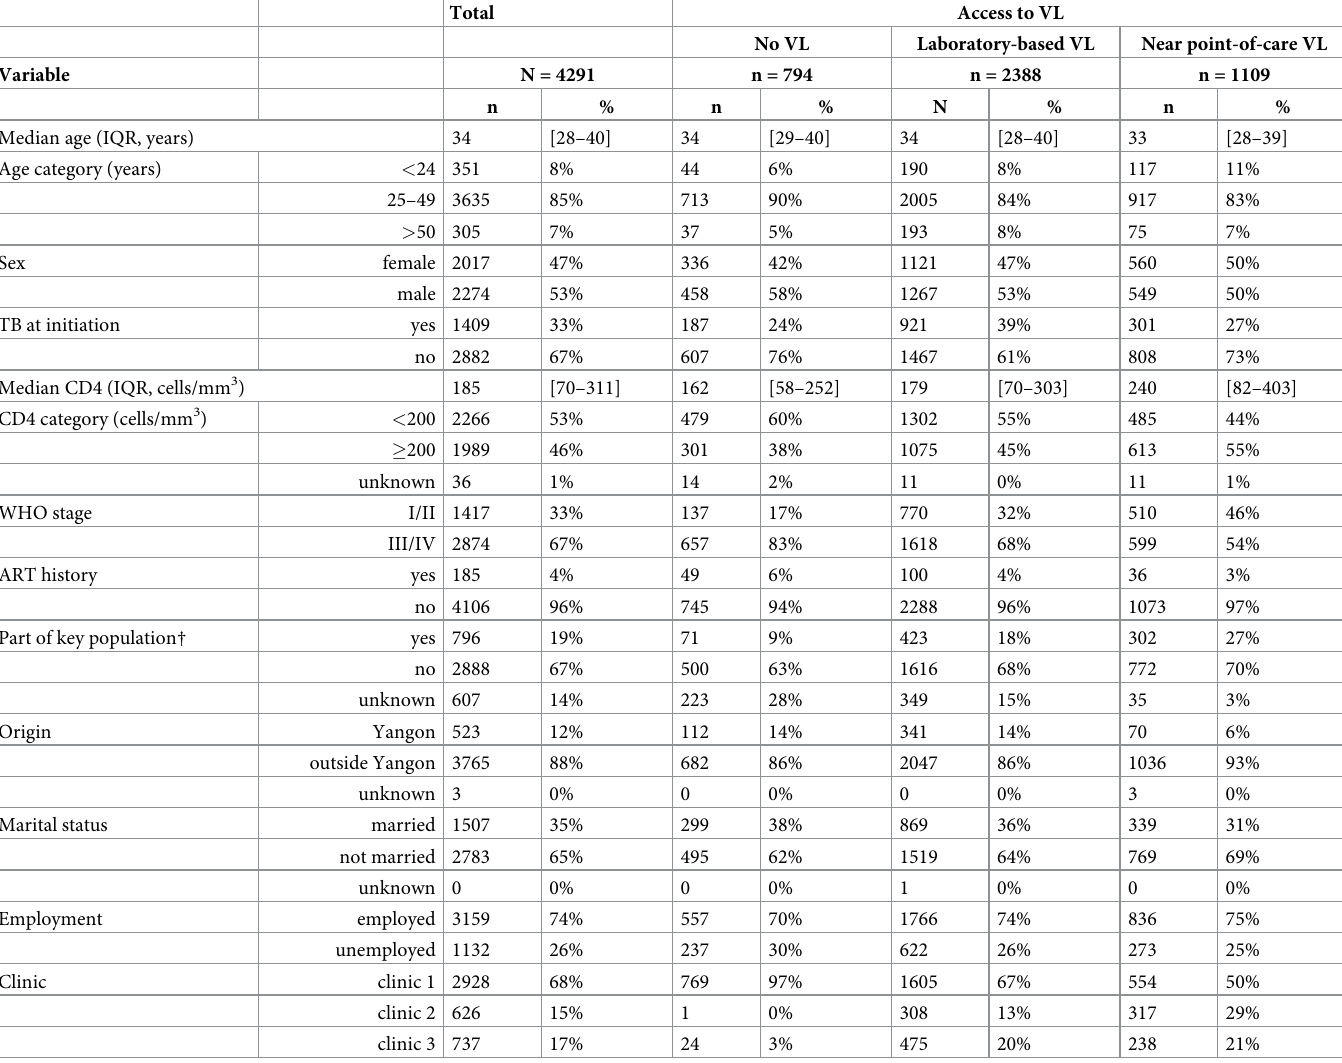
Table 1. Baseline characteristics by access to VL testing of PLHIV initiated on ART between June 2009 and July 2018 in three clinics in Yangon,